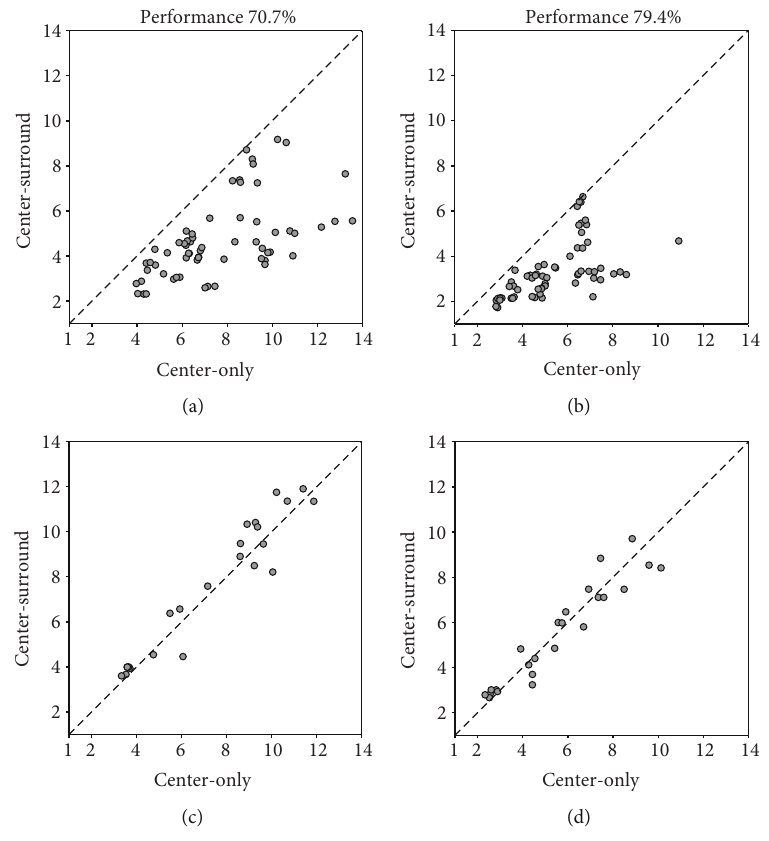
Figure 5: Scatter plots showing the neuronal contrast sensitivity value with surround stimuli (center-surround) versus without surround stimuli (center-only) at performance accuracy of 70.7% (a, c) and 79.4% (b, d) for neurons showing surround suppression e ff ect (a, b) and no surround suppression e ff ect (c, d).